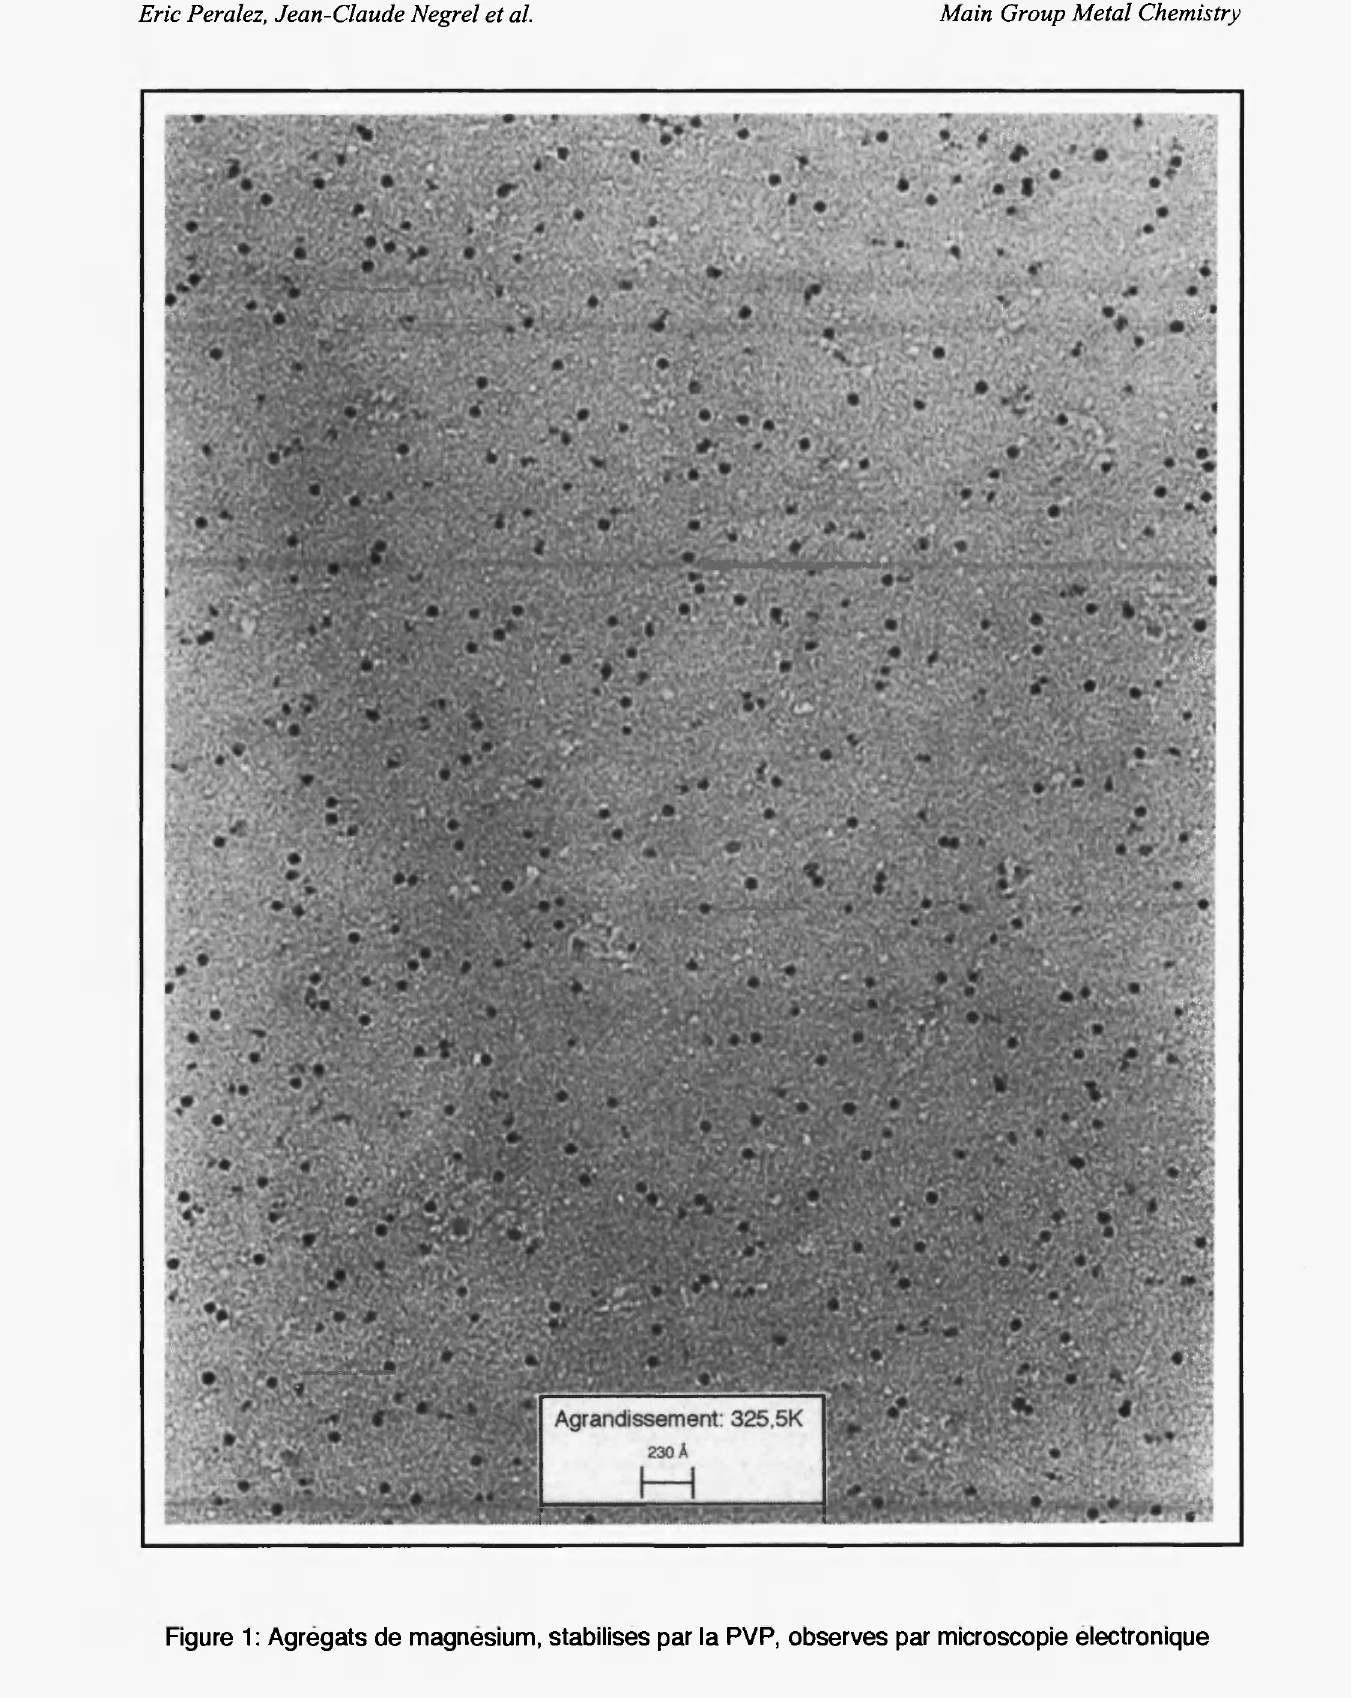
Figure 1: Agregats de magnesium, stabilises par la PVP, observes par microscopie